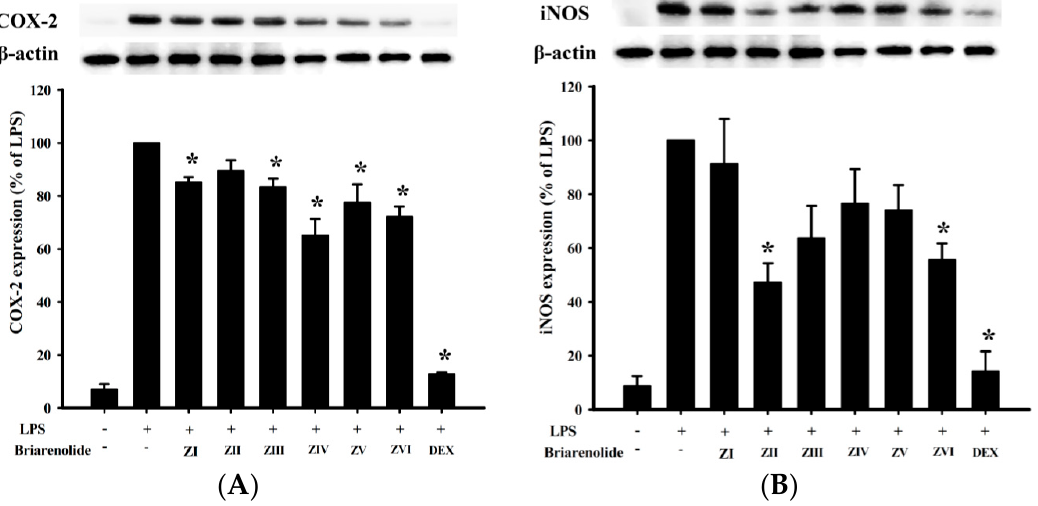
Figure 4. Effects of briarenolides ZI–ZVI ( 1 – 6 ) on pro-inflammatory cyclooxygenase 2 (COX-2) and inducible nitric oxide synthase (iNOS) protein expressions in lipopolysaccharide (LPS)-stimulated murine macrophage cell line RAW264.7. ( A ) Relative density of the COX-2 Western blot; ( B ) relative density of the iNOS Western blot. The relative intensity of the LPS-stimulated group was taken to be 100%. Band intensities were quantified by densitometry and are indicated as the percentage change relative to that of the LPS-stimulated group. Briarenolides ZII ( 2 ) and ZVI ( 6 ) and DEX significantly inhibited LPS-induced iNOS protein expression (<60%) in macrophages. The experiments were repeated three times (* p < 0.05, significantly different from the LPS-stimulated group).